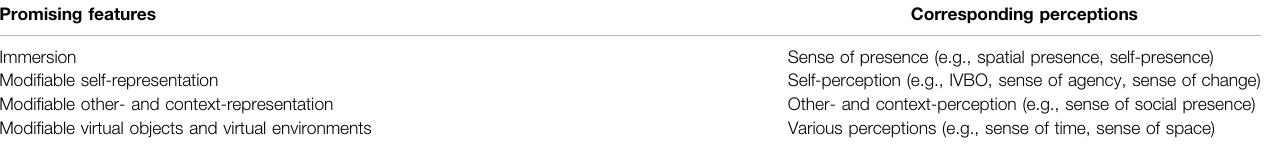
TABLE 1 | Features of immersive technologies and corresponding perceptions. Promising features Corresponding perceptions